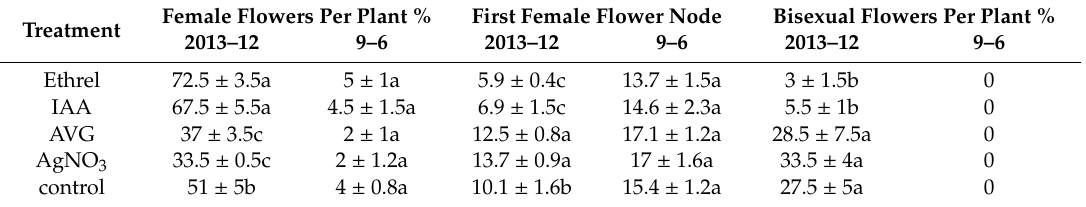
Table 3. E ff ects of di ff erent hormone treatments on sex di ff erentiation of ‘2013–12’ and ‘9–6’. Female Flowers Per Plant % First Female Flower Node Bisexual Flowers Per Plant Treatment